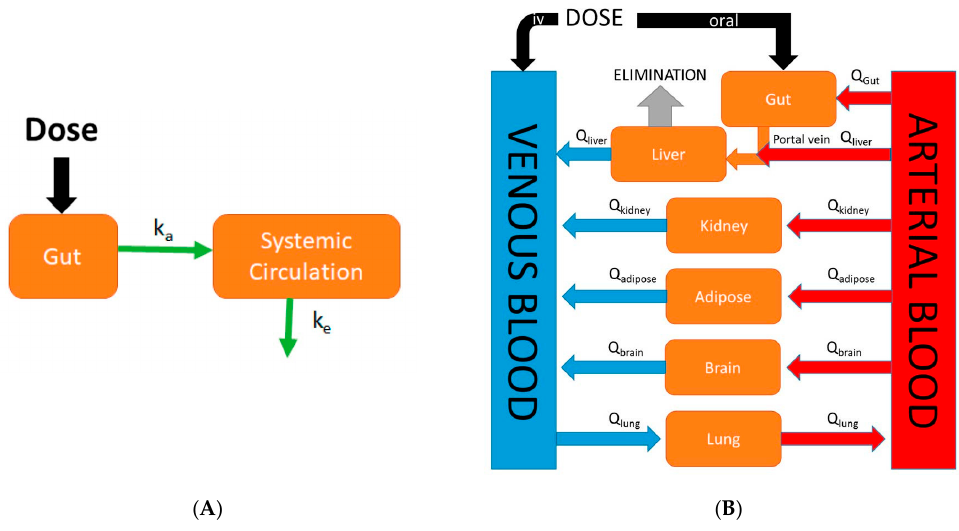
Figure 1. Comparison of an empirical classical compartmental model and a mechanistic physiologically-based pharmacokinetic (PBPK) model. ( A ) In the classical compartment model, a drug is inputted into the gut compartment, and absorption into the systemic circulation compartment is governed by the absorption rate constant (k a ). Elimination is described by the elimination rate constant (k e ); ( B ) In the whole-body PBPK model, major organs/tissues are represented by compartments, connected by blood flows (Q). Specific organ blood flows are described by subscripts. Intravenous (IV) dosing inputs drugs directly into venous blood, whereas oral dosing inputs drug into the gut compartment. In this illustration, the liver is the major eliminating organ.